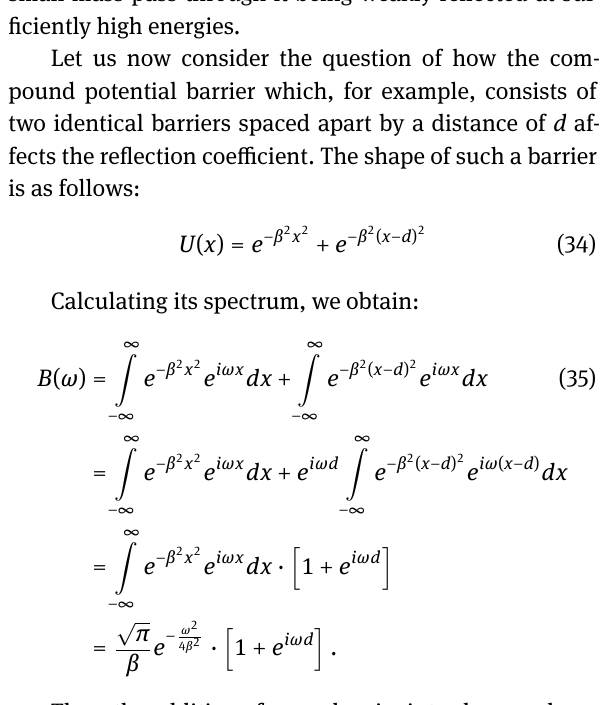
These graphs demonstrate that particles with a larger mass at the same energy E are reflected more strongly for this type of barrier, while smaller particles with a very small mass pass through it being weakly reflected at suf- ficiently high